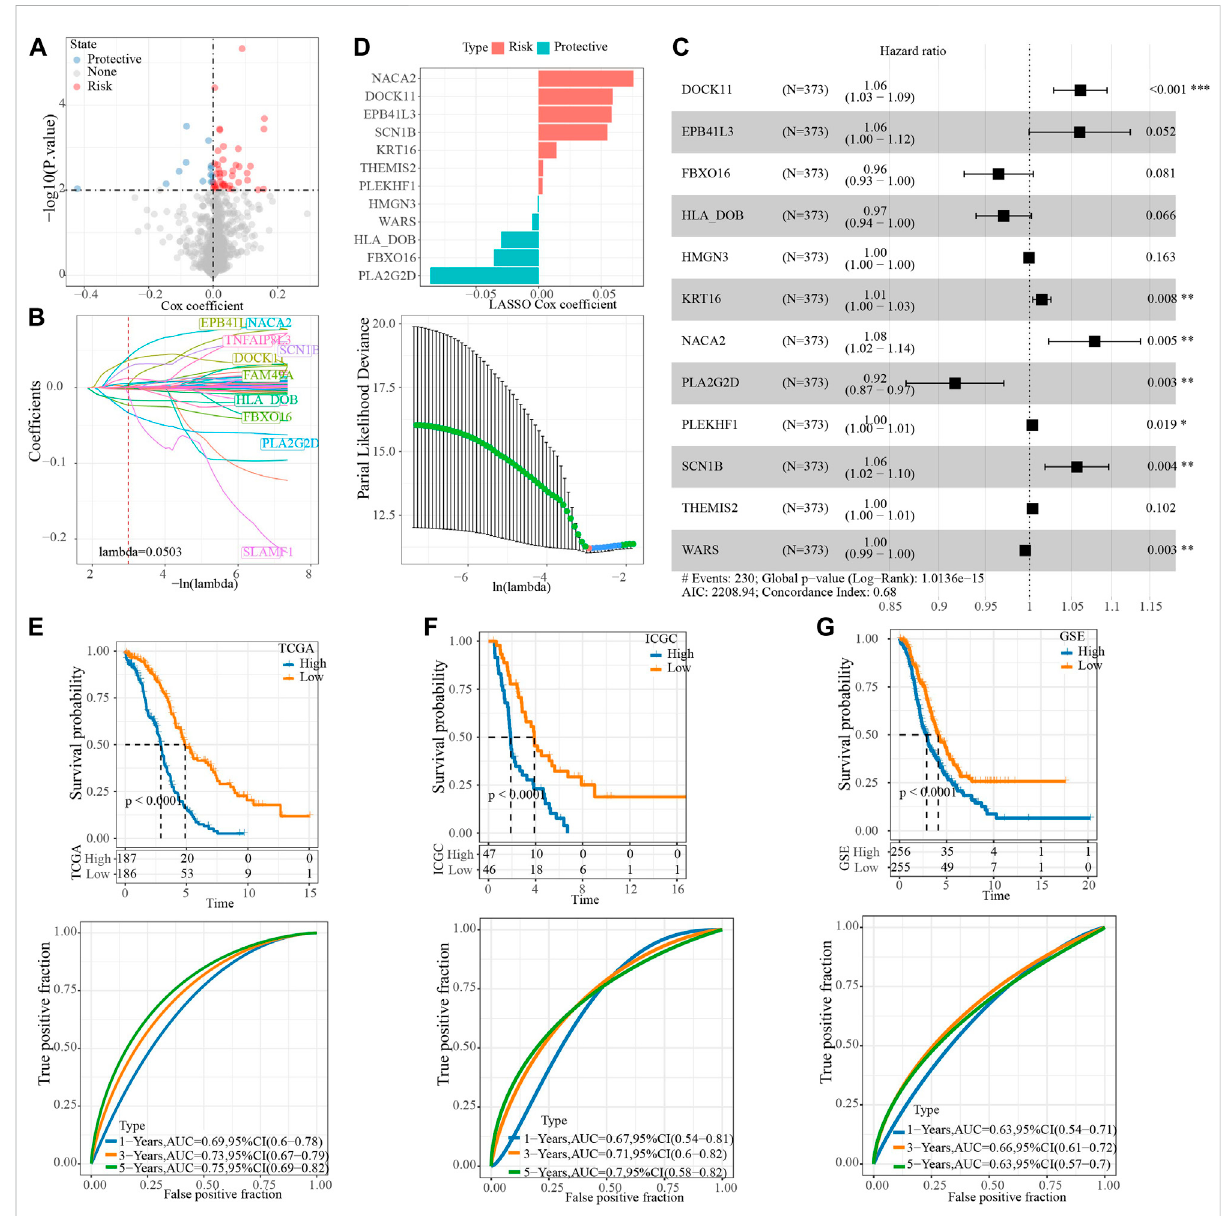
FIGURE 4 Construction of NRRS model based on hub gene in blue module. (A) The Cox coef fi cients of 55 genes related to OV survival. (B) LASSO Cox regression penalized the unimportant features in the regularization process. (C) The forest map shows the results of multivariate Cox regression analysis for 12 genes. (D) LASSO Cox coef fi cients of 12 genes. (E) Kaplan-Meier and tdROC curves of OS predicted by NRRS model in TCGA-OV cohort. (F) Kaplan-Meier and tdROC curves of OS predicted by NRRS model in ICGC dataset. (G) Kaplan-Meier and tdROC curves of OS predicted by NRRS model in GSE